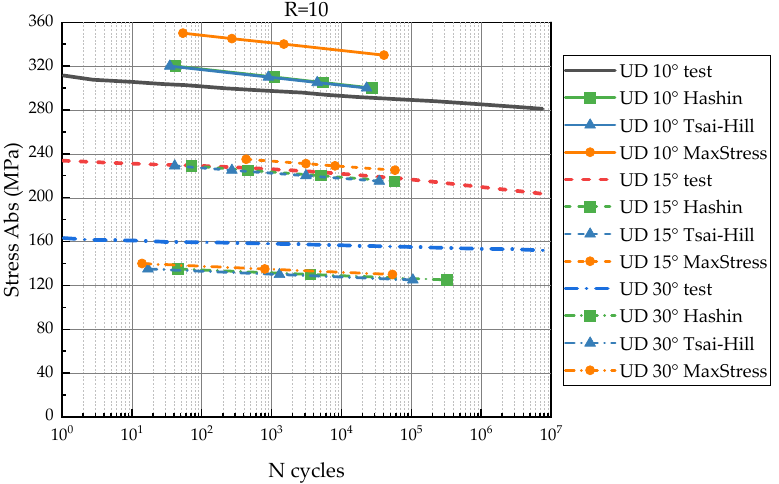
The comparison between the S-N curves for R = 10 is shown in Figure 10. It indicated less resemblance for R = 10 than for R = 0.1. Too high and too low stresses were predicted by the all-failure criteria for 10° and 30°, respectively. The failure stresses have 15% dif- ference. However, predictions for UD 15° were more accurate than for R = 0.1. Figure 9. Comparison between experimental and predicted S-N curves of UD 10, 15, 30° for R = 0.1.